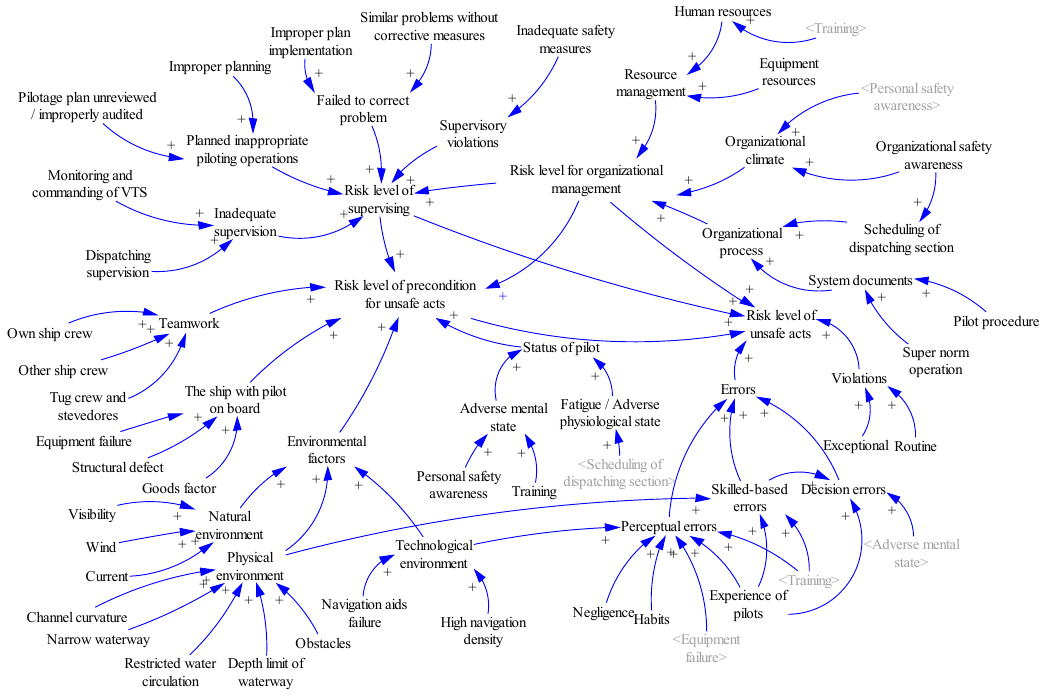
Figure 4. Causal relationship system dynamics (SD) model of maritime pilotage based on the HFACS model (Note: When an RCE appears the second time, the software producing this diagram will automatically put it in < ... >